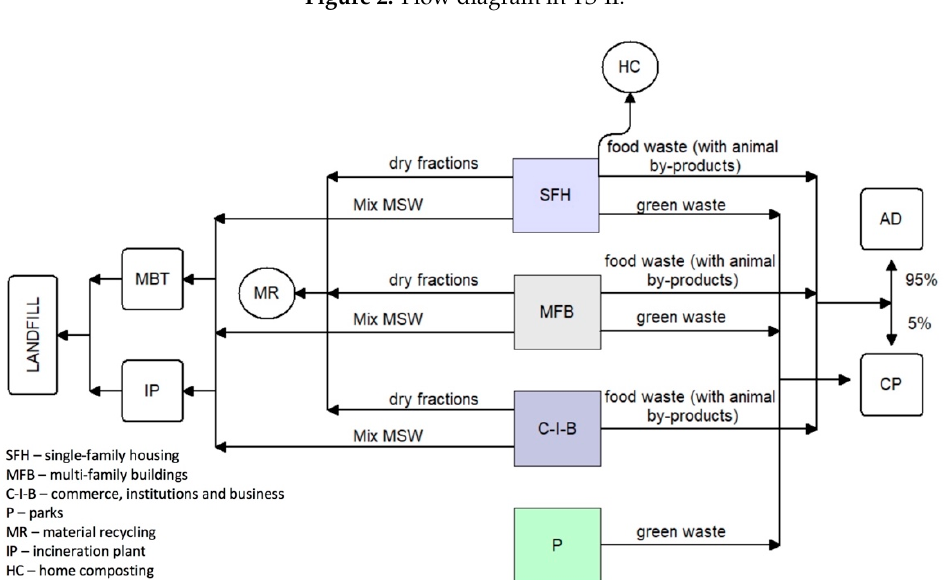
Figure 2. Flow diagram in TS ‐ II.